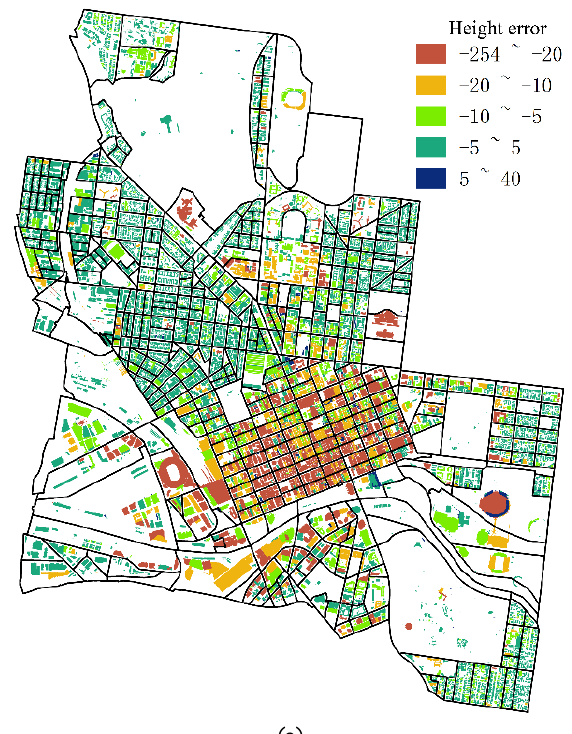
Figure 3. Building height results. (a) Estimated building height map. (b) True building height map. (c) Building height error map.